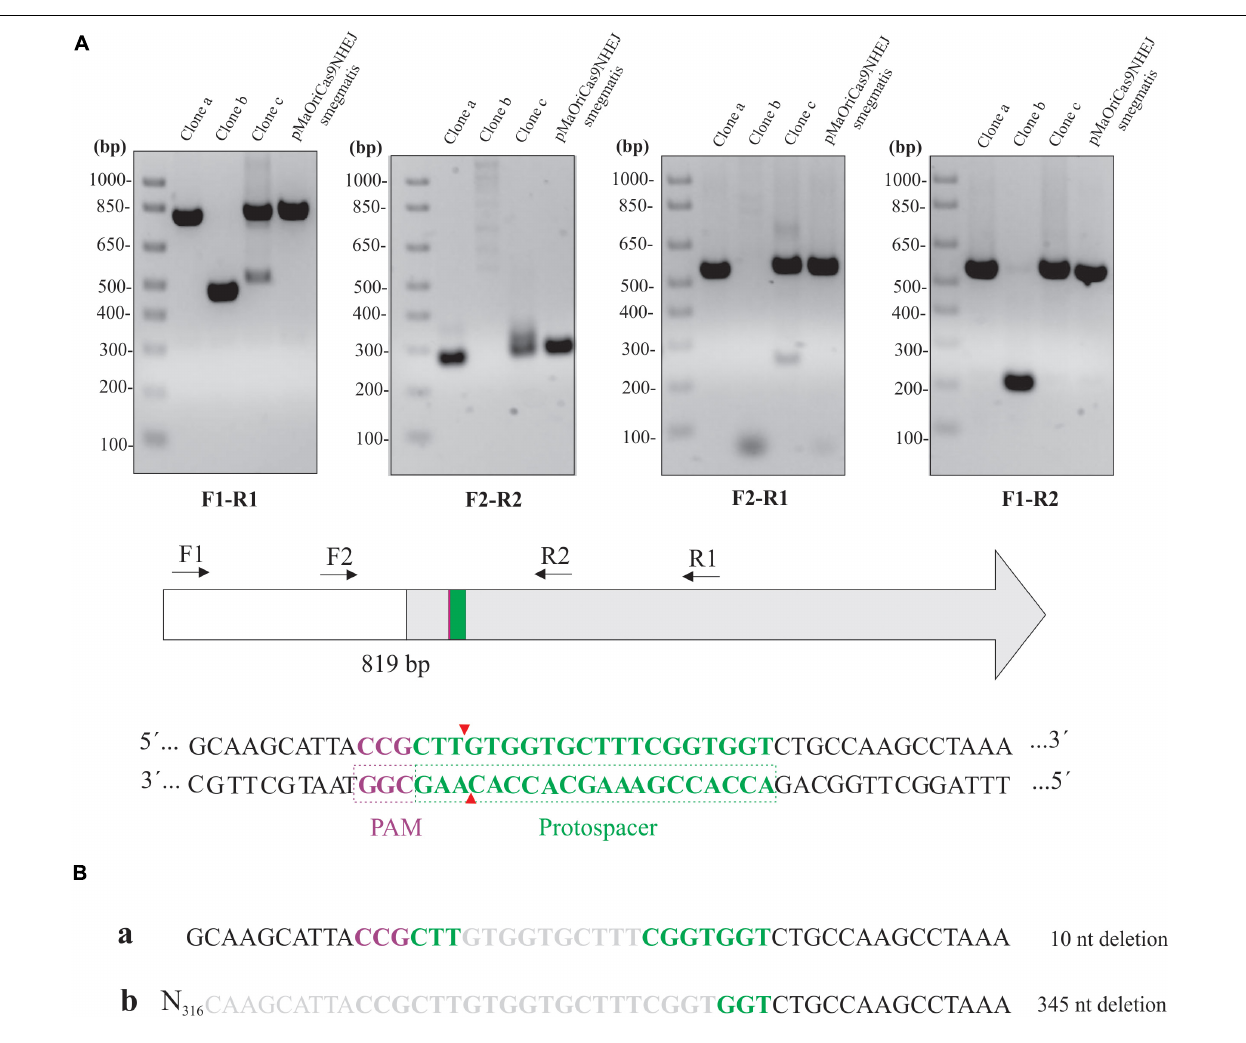
FIGURE 6 | Assessment of lipL32 sequence in L. interrogans mutants. (A) Extracted DNA from mutant clones and cells containing pMaOriCas9NHEJsmegmatis was amplified by PCR using a distinct set of primers, as depicted in the scheme showing the upstream region (white) and coding sequence of lipL32 gene (gray), protospacer, PAM NGG, and Cas9 cleavage site. (B) Amplicons from F1-R1 amplification were sequenced and were compared to the WT sequence, with deletion size shown on the